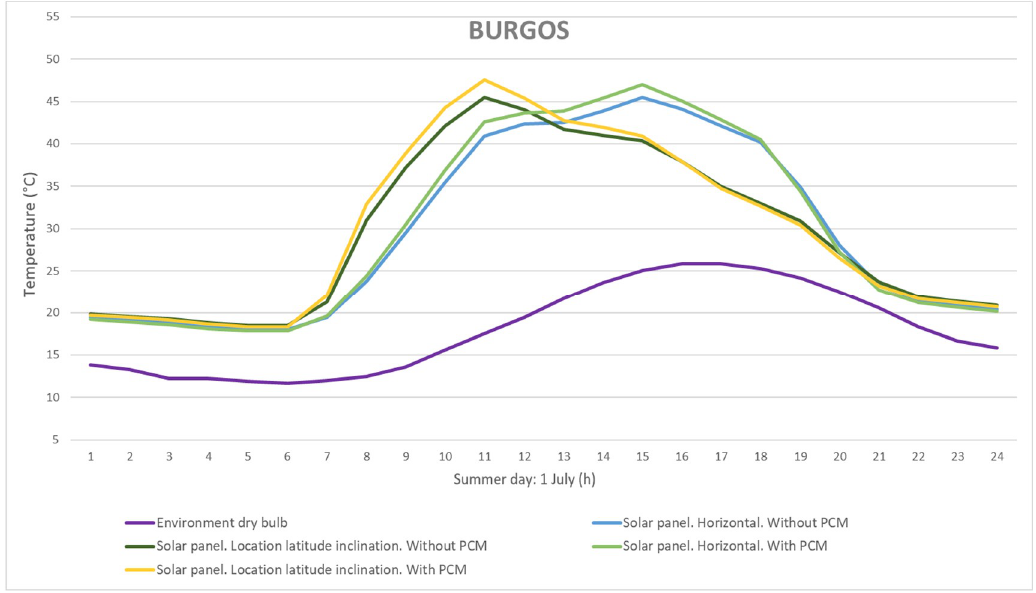
Figure 8. Estimated temperatures for a summer day in Burgos.